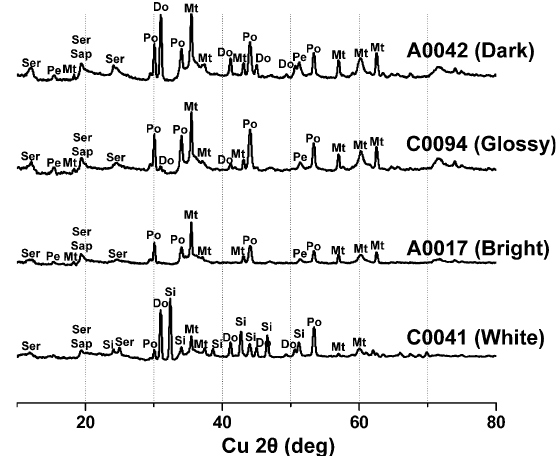
Fig. 9 Mineral combinations of each grain. Representative X‑ray diffraction patterns obtained from 100 microns‑sized fragment of each group. Each pattern was selected from the perspective that the most minerals are detected clearly. Ser: serpentine, Sap: saponite, Po: pyrrhotite, Pen: pentlandite, Mt: magnetite, Do: dolomite, Si: siderite. C0041 only shows sharp peaks of siderite